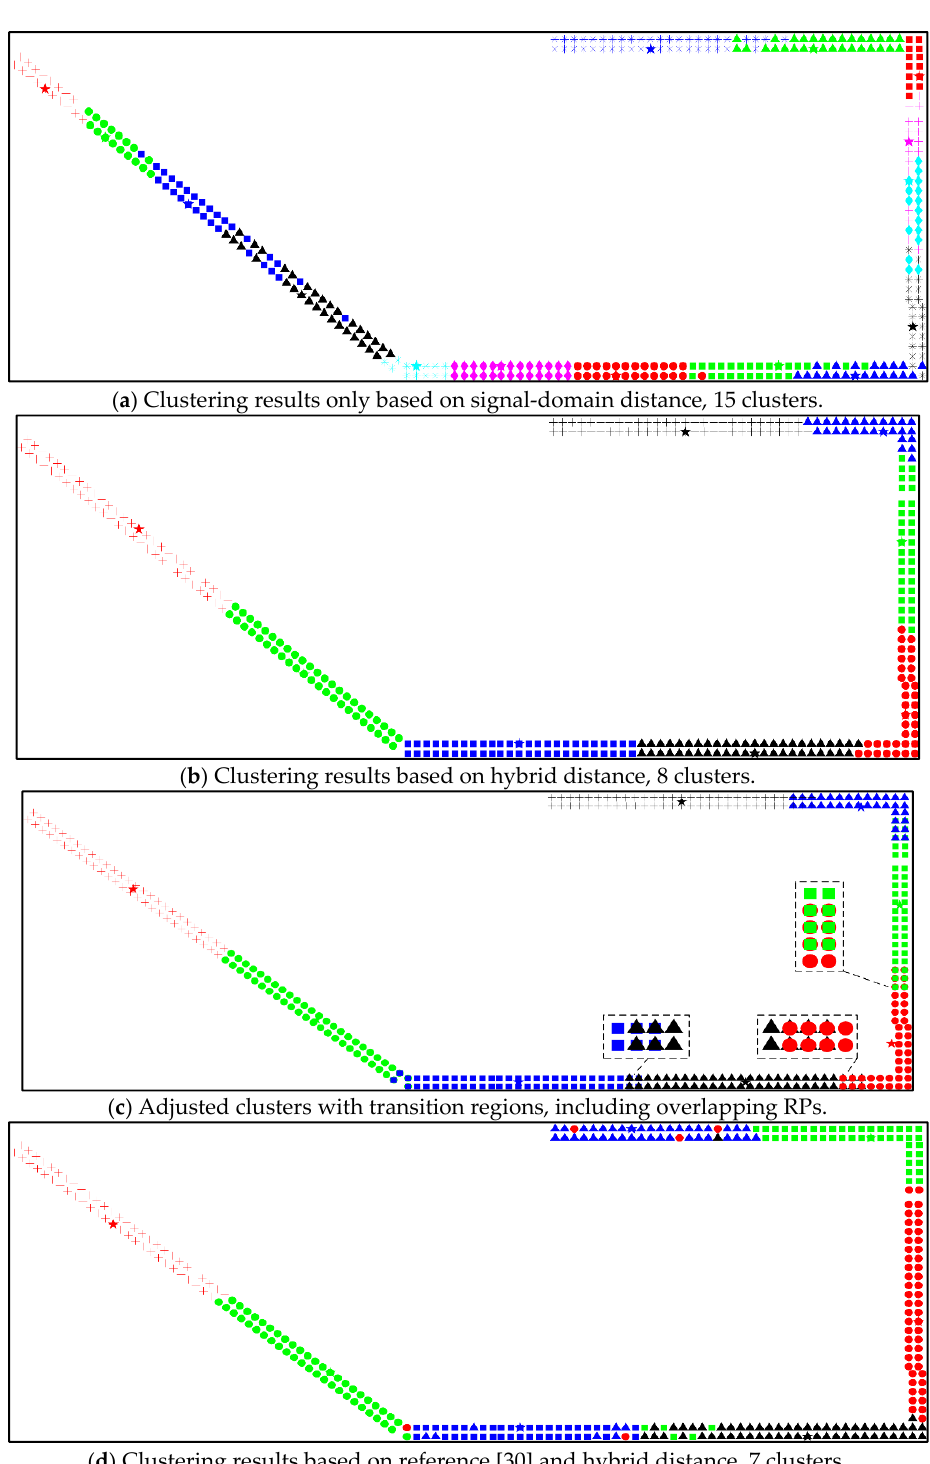
Figure 7. Clustering results based on signal-domain distance and hybrid distance, as well as adjusted clusters with transition region.